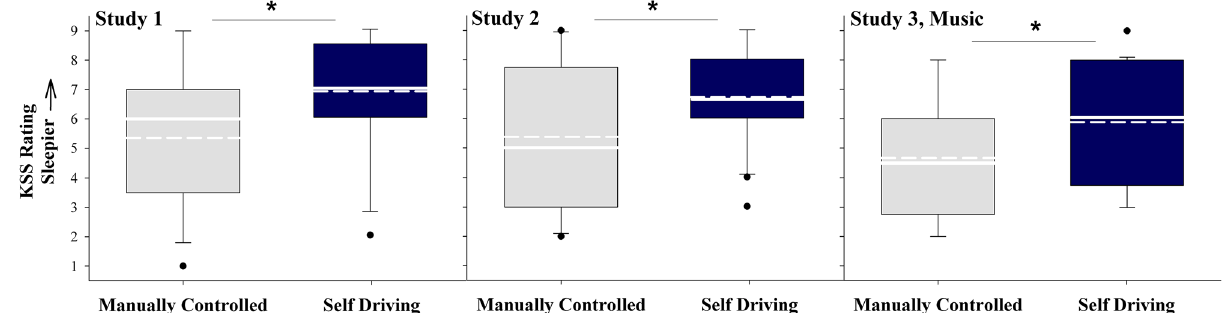
Figure 2. Self-reported sleepiness following the manually controlled and self-driving conditions for each study. Higher Karolinska Sleepiness Scale (KSS) scores indicate higher sleepiness. For each box, the solid white line indicates the median, the dashed white line indicates the mean, and the bottom and top boundaries of the box indicate the 25th and 75th percentiles, respectively. The bottom and top whiskers indicate the 10th and 90th percentiles, respectively (Study 1 n = 17; Study 2 n = 19; Study 3 n = 19). * = p < .05.